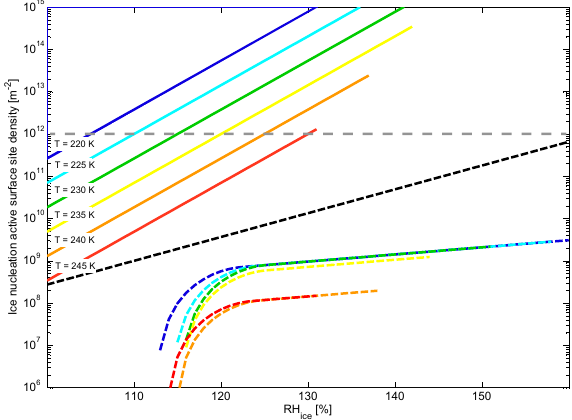
Figure 7. n s trajectories derived from experimental runs (see Ta- ble 1) – the arrow indicates decreasing temperature and increas- ing RH ice during expansion experiments (see Fig. 4); colored lines correspond to isolines of the fitted INAS density (log 10 (n s ) ) from Fig. 6 – symbols indicate ice nucleation active surface site densi- ties derived from experimental studies by other authors (same color code as for isolines).